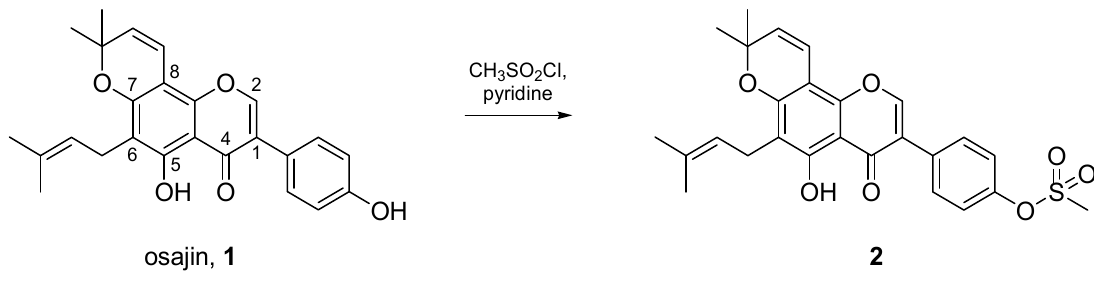
Scheme 1. Synthetic procedure for the preparation of 2 .